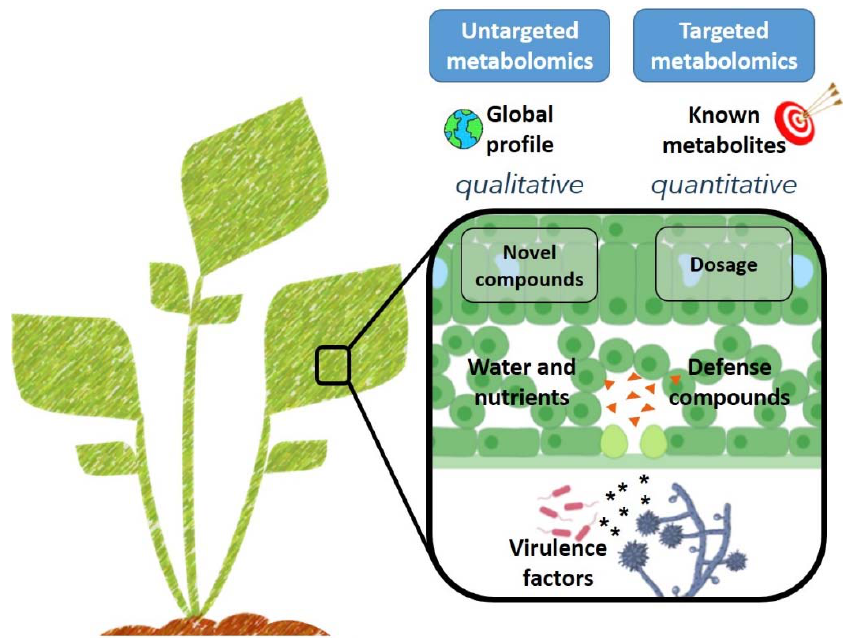
Figure 2. Metabolomics as a tool to unveil plant–pathogen interactions. The untargeted approach is qualitative and gives a global profile of many unknown metabolites in a sample. The targeted approach is quantitative and more specific, as it aims for a determined class of known compounds.